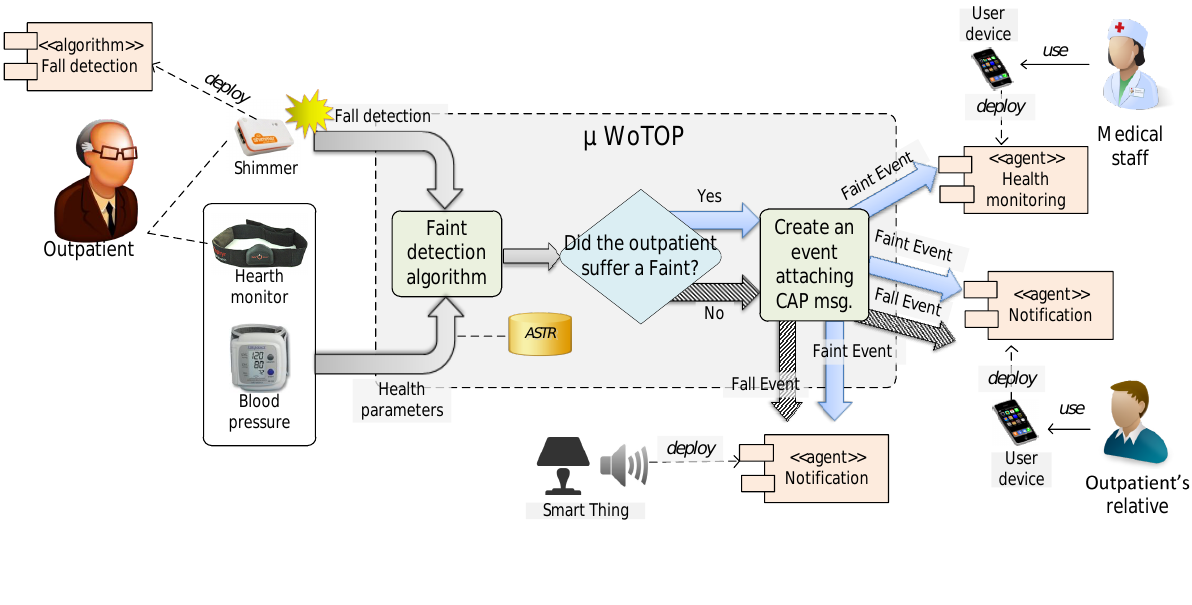
Figure 10. Motivation scenario: integral healthcare system for promoting independent living of the